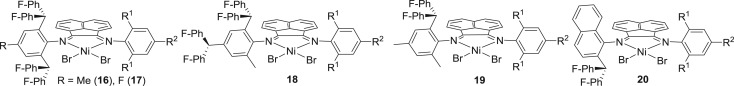
Difluorobenzhydryl-containing unsymmetrical α-diiminoacenaphthene-nickel pre-catalysts 16–20.